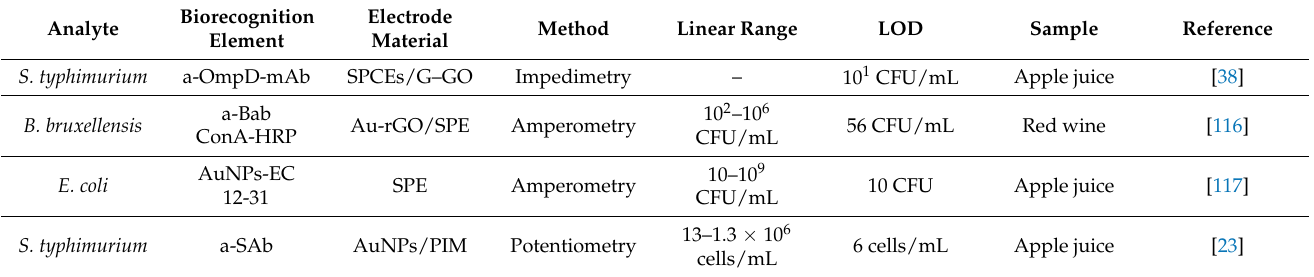
Table 6. Summary of electrochemical biosensors for various foodborne pathogens in alcoholic and non-alcoholic